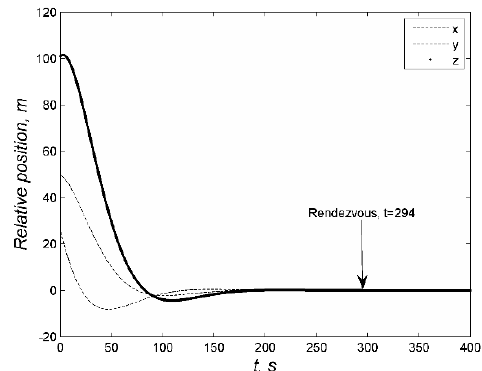
Figure 2. Relative position with respect to the target during the capturing maneuver.